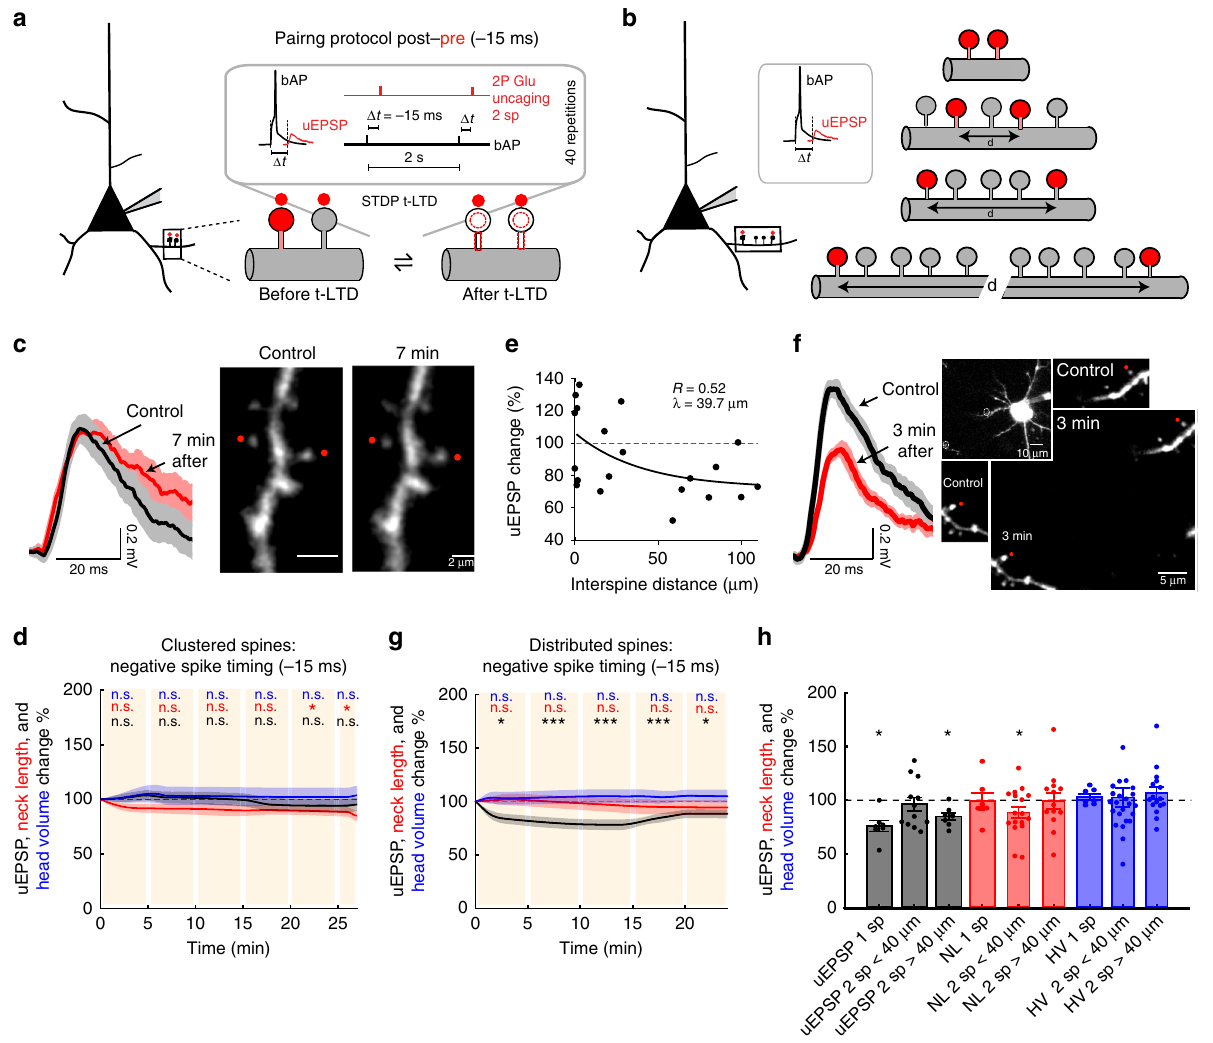
Fig. 5 Induction of t-LTD in clustered and distributed dendritic spines. Experimental protocol for t-LTD induction in a two clustered (<40 µ m) or b two distributed spines (>40 μ m apart). c Representative experiment where two clustered spines were activated with a t-LTD post – pre pairing of − 15 ms. Traces correspond to an average of 10 uEPSPs recorded in the soma and generated by 2P uncaging before (control, black trace) and after t-LTD induction (red trace) over the indicated spines (red dots) d Time course of uEPSP amplitude, the neck length and spine head volume ( P = 0.24, 0.47, and 0.32, respectively, n = 12 spine pairs, one-way repeated-measures ANOVA) of the activated clustered spines after t-LTD induction ( − 15 ms). n.s. not signi fi cant; * P < 0.05, post hoc Dunnet ’ s test. e t-LTD recovery is dependent on interspine distance. f Same as c , but for distributes spines (>40 μ m apart). Insets shows a low magni fi cation image of the recorded neuron with the marked location of the selected spines. g Time course of uEPSP amplitude, the neck length and spine head volume ( P < 0.001, P = 0.67, and P = 0.56, respectively, n = 8 spine pairs, one-way repeated-measures ANOVA) of the activated distributed spines after the induction of t-LTD ( − 15 ms). n.s. not signi fi cant; * P < 0.05, ** P < 0.01 and *** P < 0.001, and post hoc Dunnet ’ s test. h Changes in uEPSP amplitude, neck length, and head volume of individual (1 sp), clustered (2 sp < 40 µ m) and distributed spines (2 sp > 40 µ m) 15 – 25 min after the t-LTD induction ( − 1 ms) (clustered: uEPSP = 95.65 ± 6.42%, P = 0.62; neck length = 88.07 ± 5.58%, P = 0.04; spine head volume = 102.08 ± 8.94%, P = 0.38, n = 12 spine pairs; distributed: uEPSP = 84.40± 3.12%, P = 0.016; neck length = 98.78 ± 3.12%, P = 0.68; spine head volume = 105.84 ± 5.56%, P = 0.50, n = 8 spine pairs, two-sided Wilcoxon test; * P < 0.05). Shaded area and error bars represent SEM. Lines, bars, and dots in d , g , h : uEPSP = black, neck length (NL) = red, and head volume (HV) =